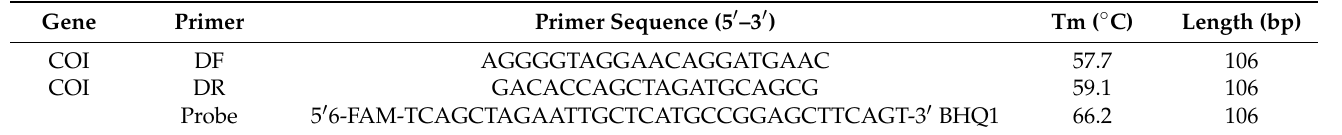
Table 1. Primer pairs (DF-Forward, DR-Reverse) and the probe used for qPCR analysis of environ- mental DNA and